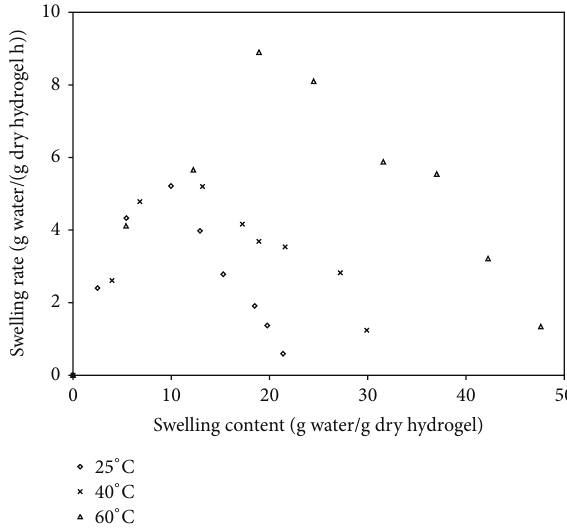
Figure 4: Swelling kinetic curves for hydrogel at different tempera-